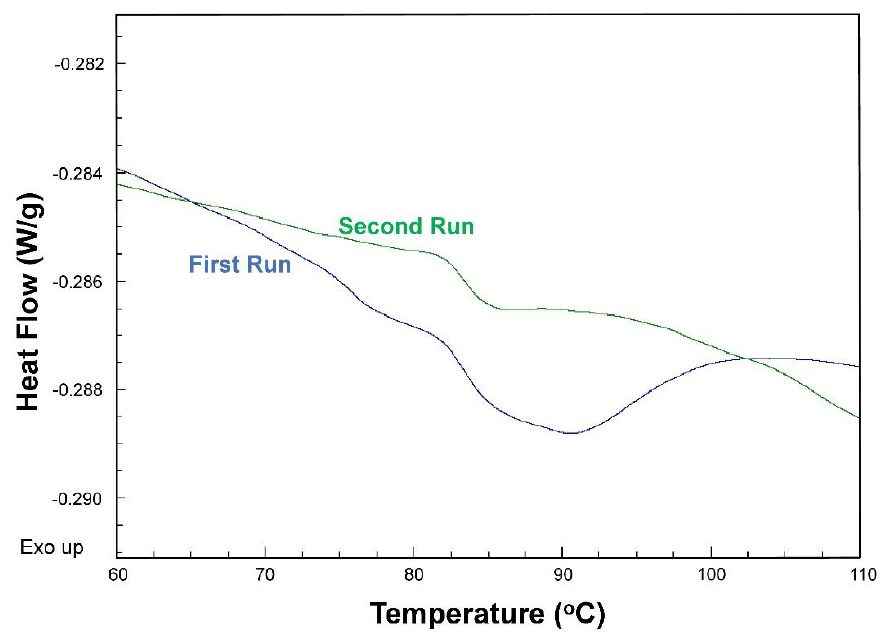
Figure 1. Differential scanning calorimetry (DSC) profile (heat flow versus temperature) of fava bean protein solutions when heated at 1 °C min −1 . The solution was heated (first run), cooled, then heated again (second run), which shows the thermal transitions are partially irreversible.